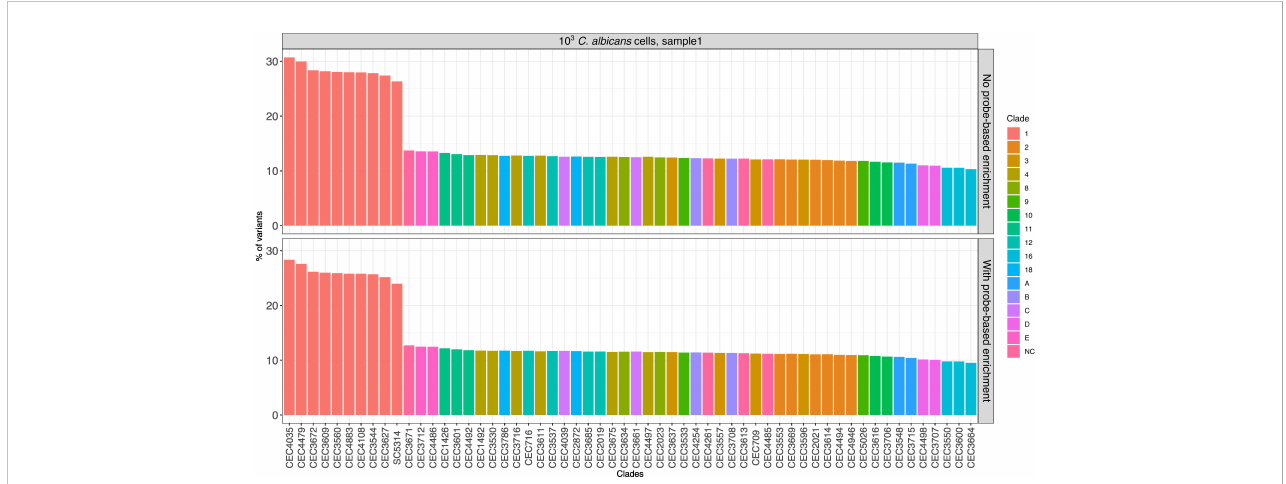
FIGURE 4 Comparison of variants of enriched and non-enriched sample ( “ N ” ) with previously published C. albicans strains. Each bar represents the proportion (in %) obtained by dividing the number of variants in common between the strain used in this study and a given published strain by the total number of variants of the published strain. Only the data of one sample from the 10 3 fungal load are shown (see Figure S6 for all samples from treatment “ N ”